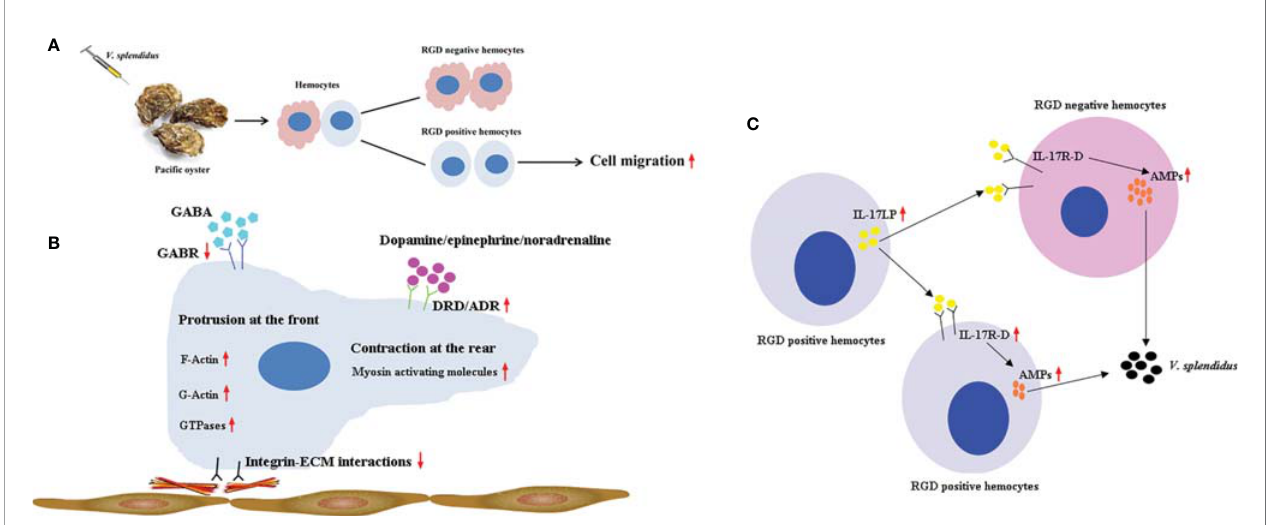
FIGURE 10 | A supposed path to enhance antimicrobial immunity mediated by RGD + hemocytes in C. gigas . (A) The migration activity of C. gigas RGD + hemocytes was enhanced by stimulation with V. splendidus . (B) The molecular mechanisms for the mediation of high migration activity in C. gigas RGD + hemocytes. The downregulation of integrin – ECM interactions and the upregulation of migration-promoting genes and migration-related genes enhanced the migration activity of RGD + hemocytes in response to V. splendidus infection. In addition, the migration activity of RGD + hemocytes was regulated by neuroendocrine factors, among which the excitatory neuroendocrine factor dopamine especially promoted the migration of RGD + hemocytes. (C) The molecular mechanisms for the regulation of antimicrobial immunity of C. gigas RGD + hemocytes. RGD + hemocytes highly expressed the immunomodulatory factor IL-17s and their receptor genes, which might promote the production of AMPs in whole hemocytes to enhance antimicrobial